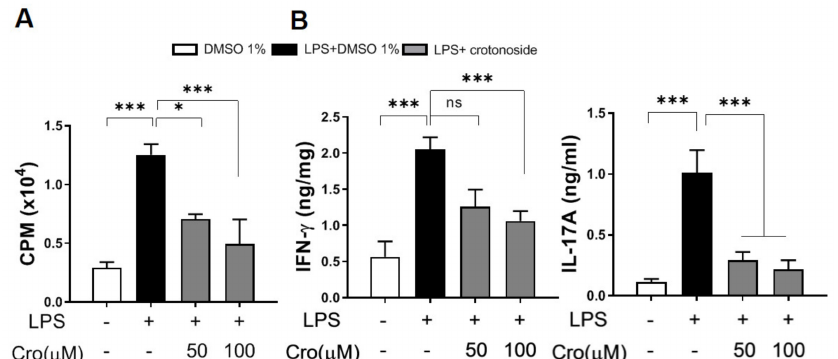
Figure 8. Crotonoside inhibited Ag-specific CD4 + T-cell proliferation and cytokine production of LPS-stimulated BMDCs. BMDCs which were activated by OVA and LPS were co-cultured with OT-II-specific T cells followed by determination of ( A ) T cell proliferation via 3H-TdR incorporation assay and ( B ) IFN- γ and IL-17A productions secreted from OT-II CD4 + T cells via sandwich ELISA. Values represented as mean ± SD in triplicate and bar graphs represent one of three independent experiments. * p < 0.05, *** p < 0.001 versus the group of LPS + 0.1% DMSO mock control, as determined by one-way ANOVA with Dunnett test.